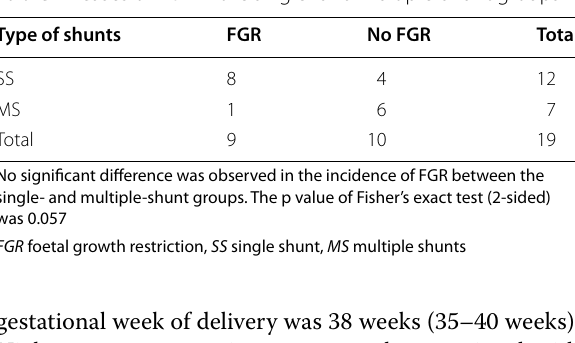
Table 2 Cases of FGR in the single- and multiple-shunt groups